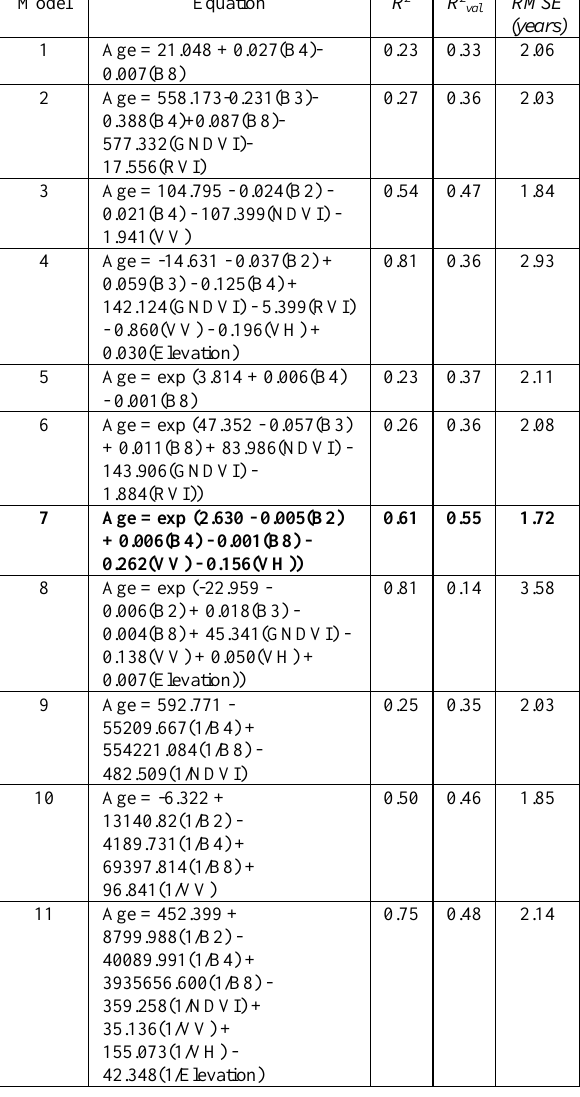
Table 4 . Multivariate regression models for Falcata stand age estimation. The R 2 val and RMSE values were computed using the validation